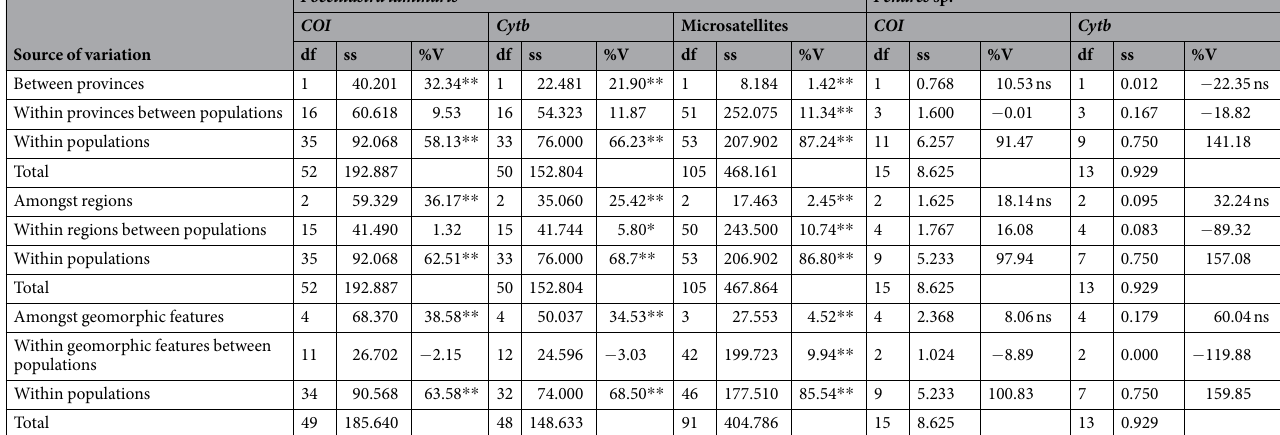
Table 1. Hierarchical AMOVA results for Poecillastra laminaris and Penares sp. when tested for genetic variation at mitochondrial genes. df = degree of freedom, ss = sum of squared observations, %V = percentage of total variance. Significant values of p < 0.05 are marked as * , and p < 0.01 are marked as ** , and p > 0.05 are marked as